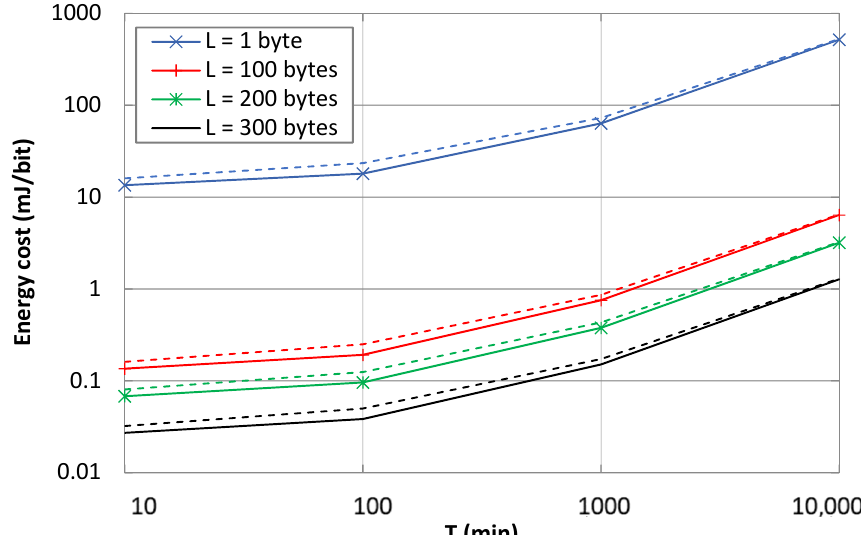
Figure 10. Energy cost vs. T, for several message payload sizes and p values. Dashed curves represent the energy cost values for p = 0.1 for the payload sizes illustrated with the same color.